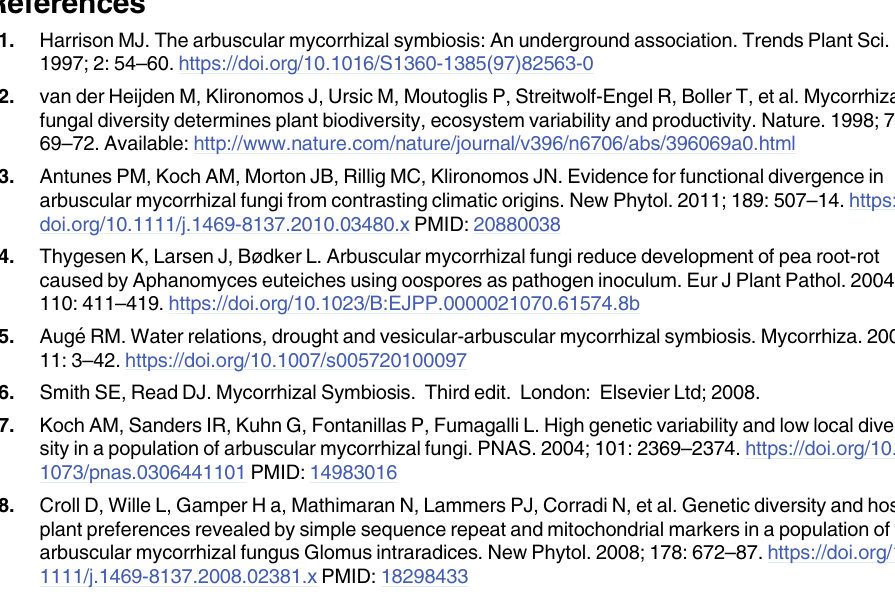
S9 Table. Identification of single-copy orthologues in long-reads data and recombination